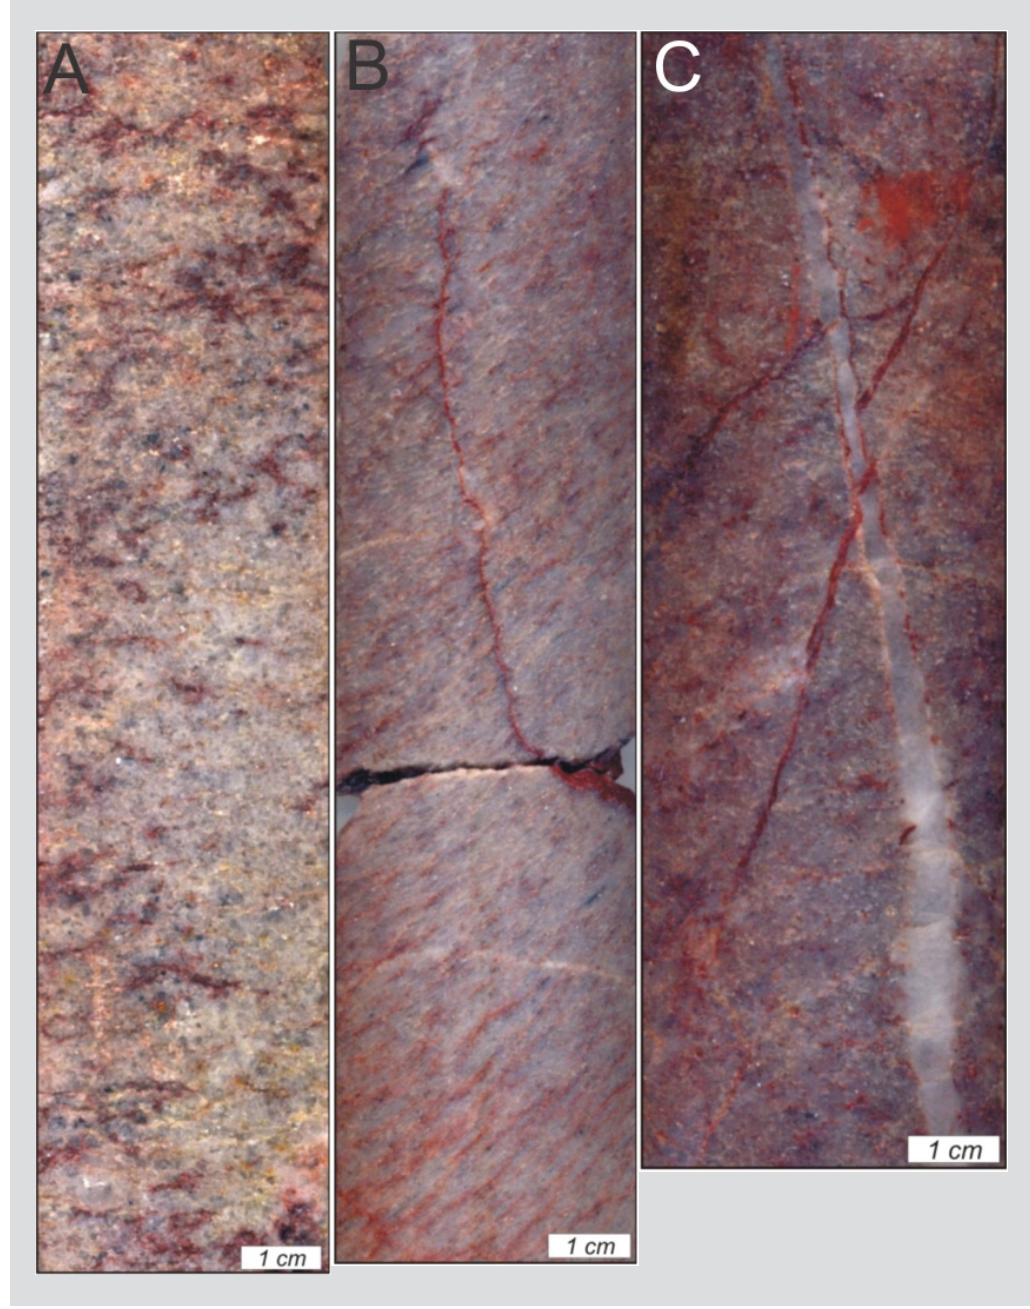
Figure 8 - Mesoscopic aspects of metasandstones. (A) Medium-grained, massive metasandstone, with local impregnation of secondary iron oxides. (B) Deformed (mylonitic) metasandstone with impregnation of secondary iron oxides. (C) Quartz veinlet cutting across mylonitic